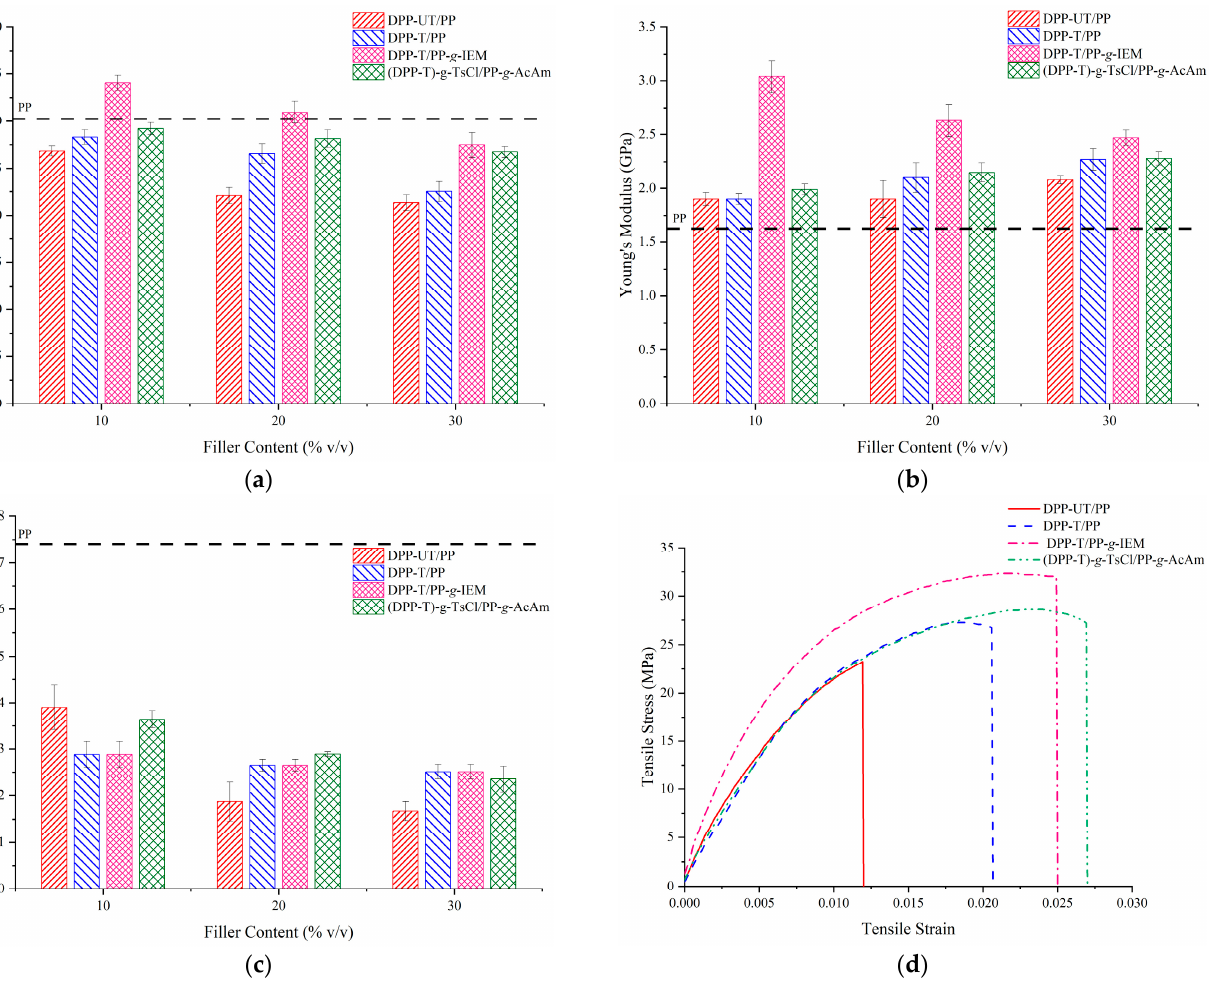
Figure 9. The tensile properties of the developed bio-composites at 20% DPP filler content: ( a ) tensile strength; ( b ) Young’s modulus; ( c ) elongation at break; ( d ) stress–strain